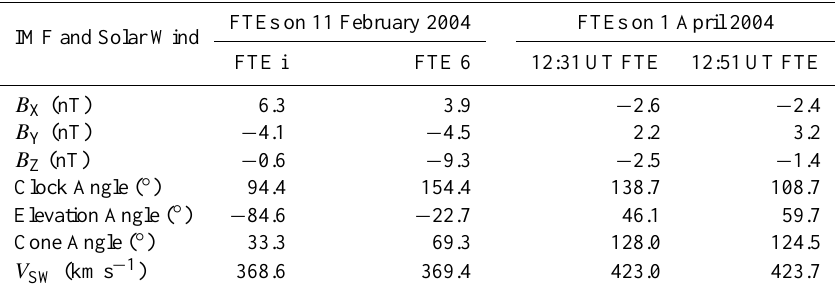
Table 2. The IMF and solar wind conditions at the core time of FTE i observed by TC-1 and the FTE 6 measured by Cluster on 11 Febru- ary 2004, and of the 12:31UT FTE and 12:51 UT FTE on 1 April 2004 (reported by Zhang et al.,